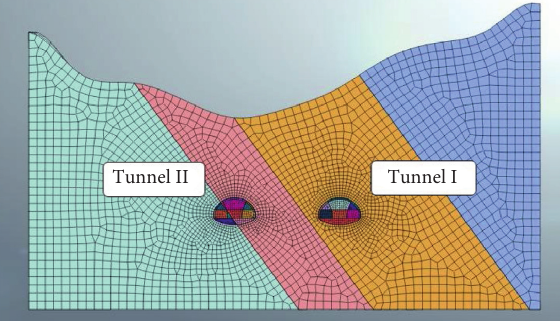
Figure 4: Model of the double-side guide pit method.